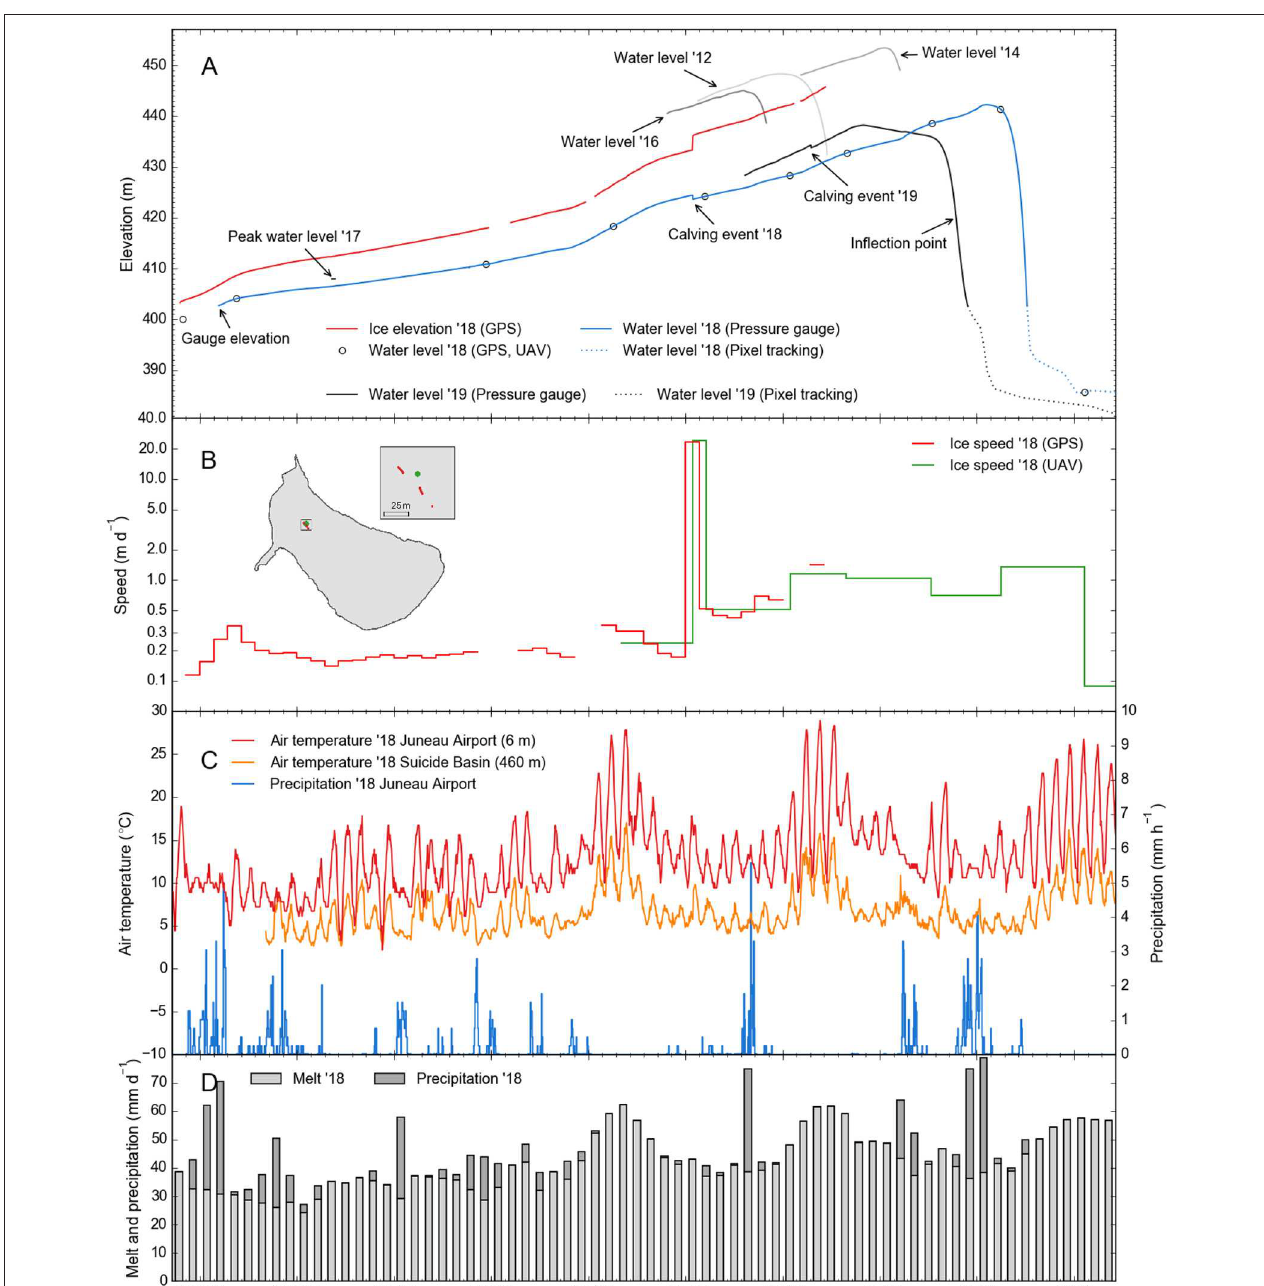
FIGURE 7 | (A) Time series of water and ice elevation in Suicide Basin observed during the 2018 season (red and blue lines). Water levels for other seasons are plotted in gray tones, with rising limbs truncated to improve readability. In 2018, the on-ice GPS had intermittent data gaps early in the time series and failed to record the latter part of the time series because of a turned-over solar panel. (B) Horizontal speeds measured by the on-ice GPS (red curve, daily resolution) and sampled from the UAV-derived velocity fields (green curve, resolution dictated by the timing of the UAV campaigns). The inset map shows the GPS path (red trace) relative to the sampling location of the UAV-derived velocity fields (green point). During the calving event on 25 June, the floating tongue detached from the main glacier, with daily speeds increasing sharply to 25 m (note the logarithmic scale on the vertical axis). (C) Air temperature and hourly precipitation measured at Juneau Airport and in Suicide Basin. (D) Modeled daily melt and precipitation at the mass balance index site at the basin entrance at an elevation of ∼ 455 m.